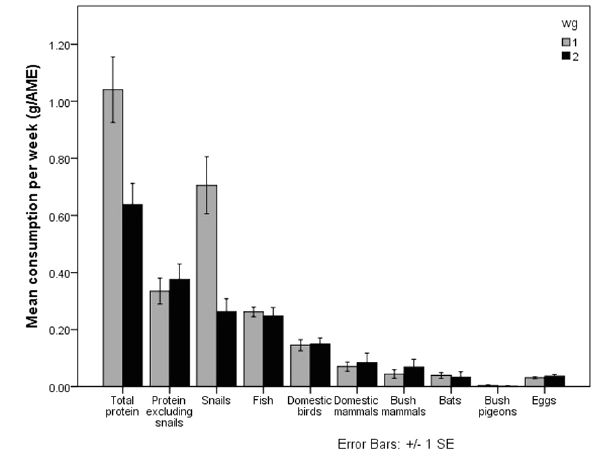
Fig. 3 . Average protein intake of each food type per wealth group. (1) lower wealth indicators, (2) higher wealth